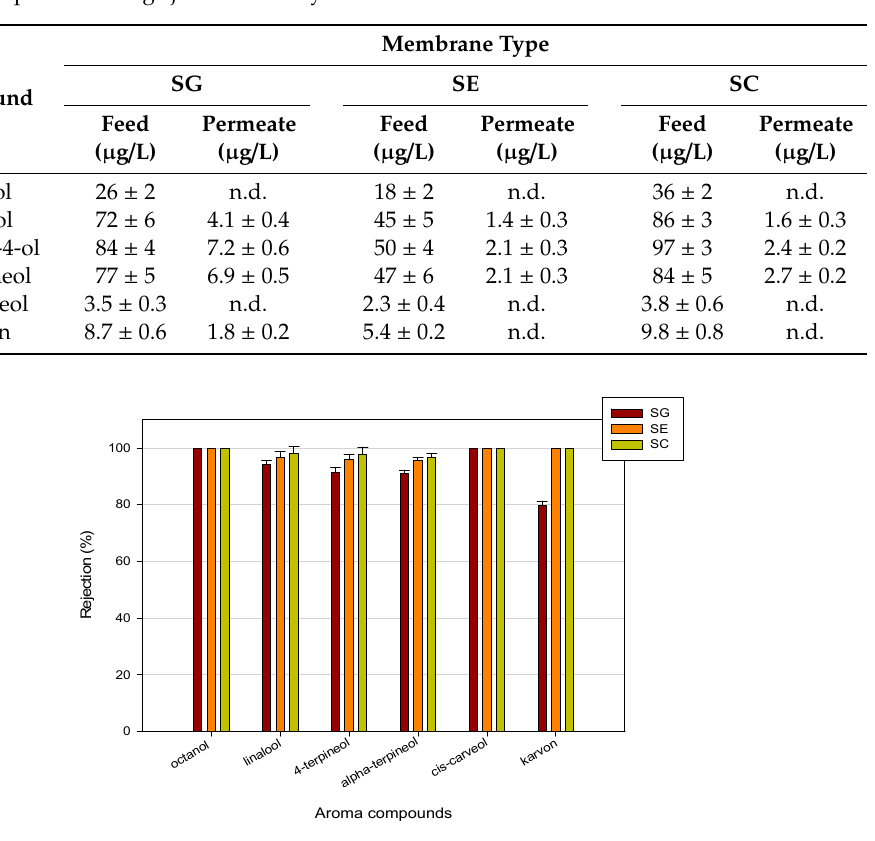
8 of 12 Figure 5. RO of evaporator condensate stream. Effect of volume concentration ratio (VCR) on the